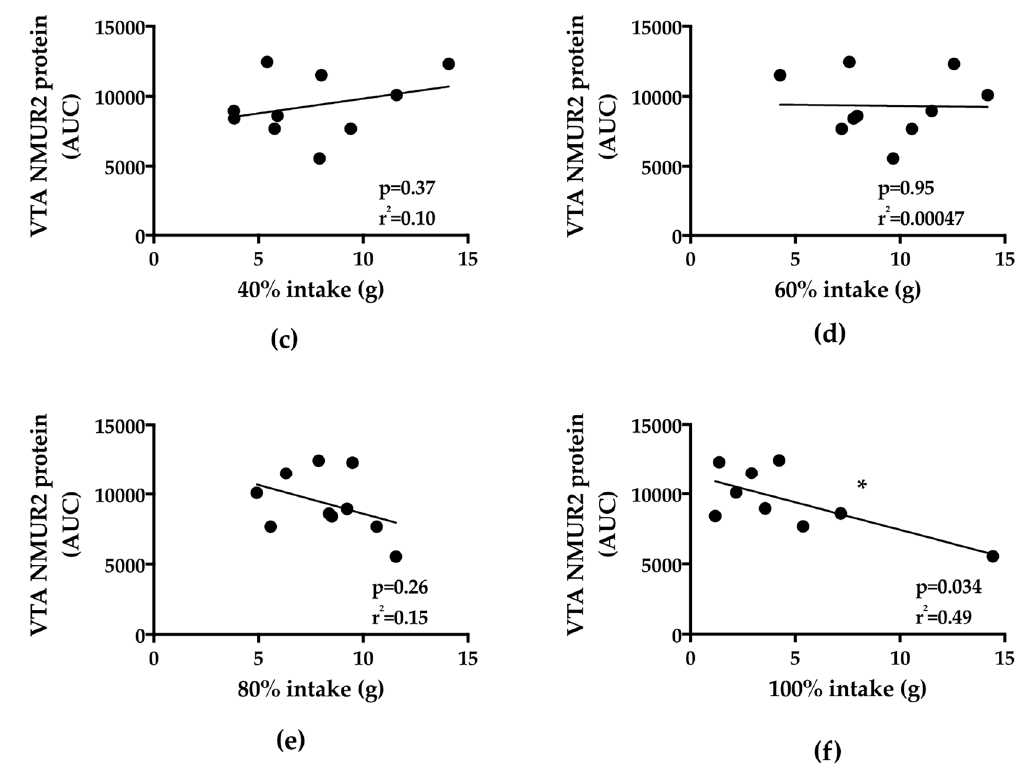
Figure 4. VTA NMUR2 protein expression was negatively correlated with binge-type eating. ( a ) representative Western blot image for NMUR2 synaptosomal protein from VTA samples; ( b ) VTA NMUR2 expression was not correlated with intake of a 20% fat (80% carbohydrate) mixture; ( c ) VTA NMUR2 expression was not correlated with intake of a 40% fat (60% carbohydrate) mixture; ( d ) VTA NMUR2 expression was not correlated with intake of a 60% fat (40% carbohydrate) mixture; ( e ) VTA NMUR2 expression was not correlated with intake of an 80% fat (20% carbohydrate) mixture; ( f ) VTA NMUR2 expression was negatively correlated with intake of a 100% fat (0% carbohydrate) mixture. * p < 0.05.